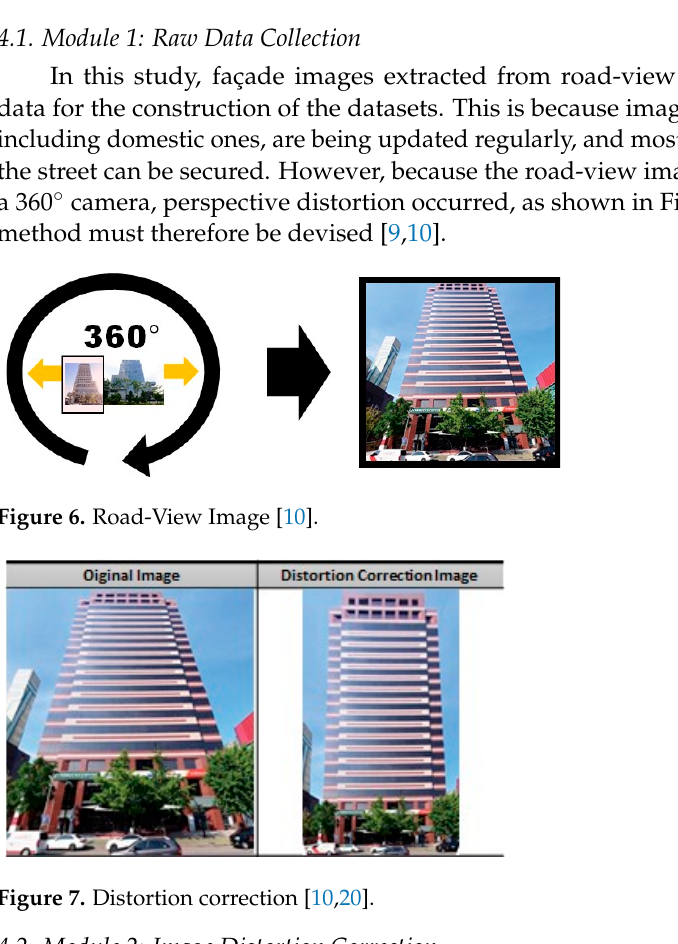
Figure 5. Framework of the proposed construction method.